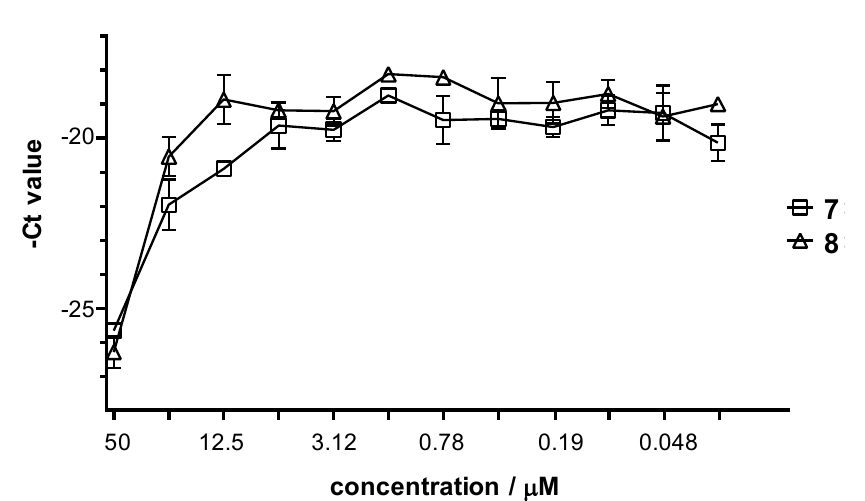
Figure 2. Antibacterial effect of complexes 7 and 8 against Chlamydia trachomatis . Figure 2 . Antibacterial effect of complexes 7 and 8 against Chlamydia trachomatis. Since the growth-related chlamydial DNA concentrations were measured by a qPCR method, the potential direct impact of the complexes on the DNA polymerase of the qPCR [31] was also tested (Figure S3). The obtained results suggest that there is no stimulation or inhibition during the